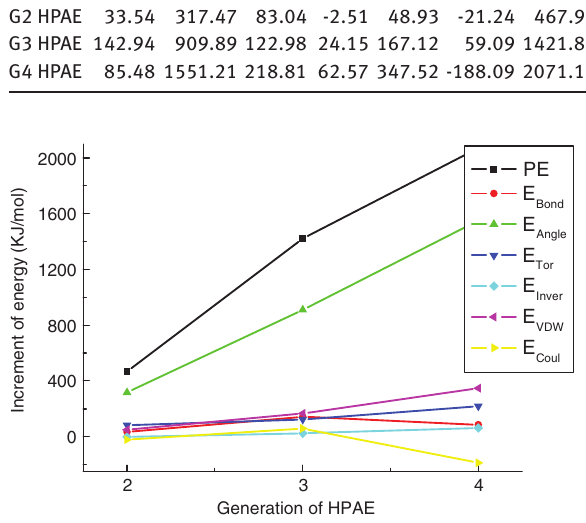
Figure 5 Relationship between HPAE/Nd energy curves and